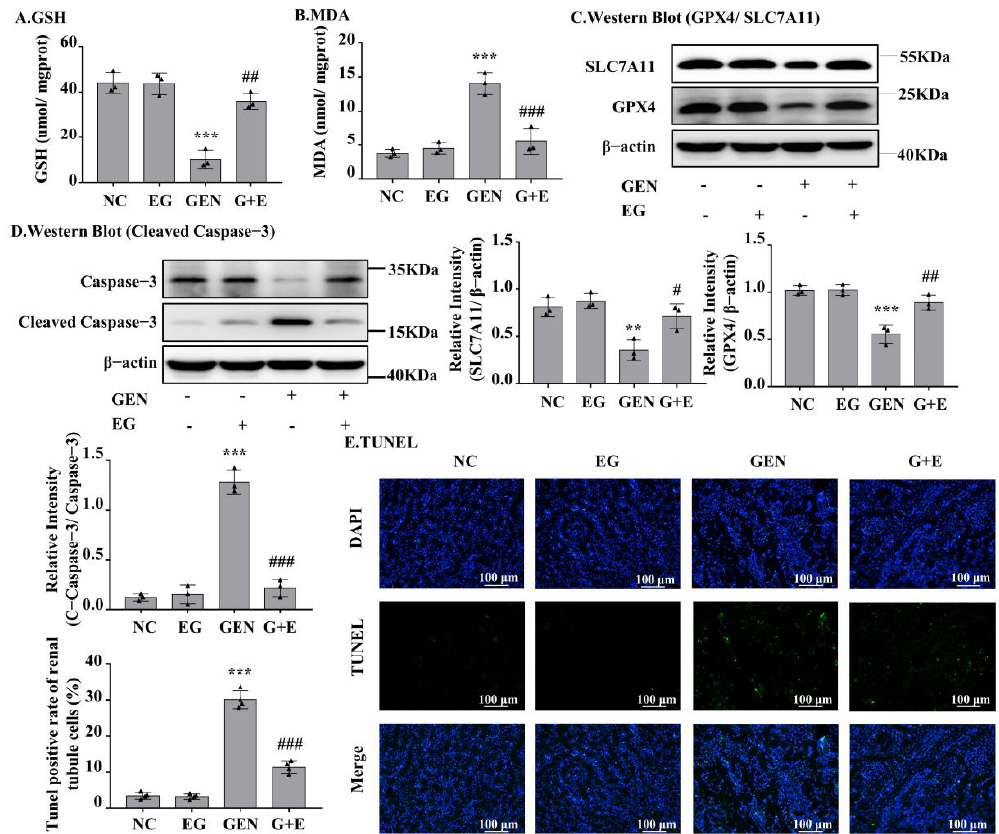
Figure 2. EG significantly decreased GEN-induced renal cell apoptosis and ferroptosis in SD rats. ( A ) Glutathione (GSH) level in kidney tissue samples. ( B ) Malondialdehyde (MDA) level in kidney tissue samples. ( C ) The Western blot analysed the levels of SLC7A11 and glutathione peroxidase 4 (GPX4) in SD rat kidney. ( D ) The Western blot analysed the level of cleaved-caspase-3 protein in SD rat kidney. ( E ) TUNEL staining of the rat kidney. Scale bars = 100 μm. In vivo data was expressed as mean ± SEM of three or four rats. ** p < 0.01, *** p < 0.001 vs. control group; # p < 0.05, ## p < 0.01, ### p < 0.001 vs. GEN group.